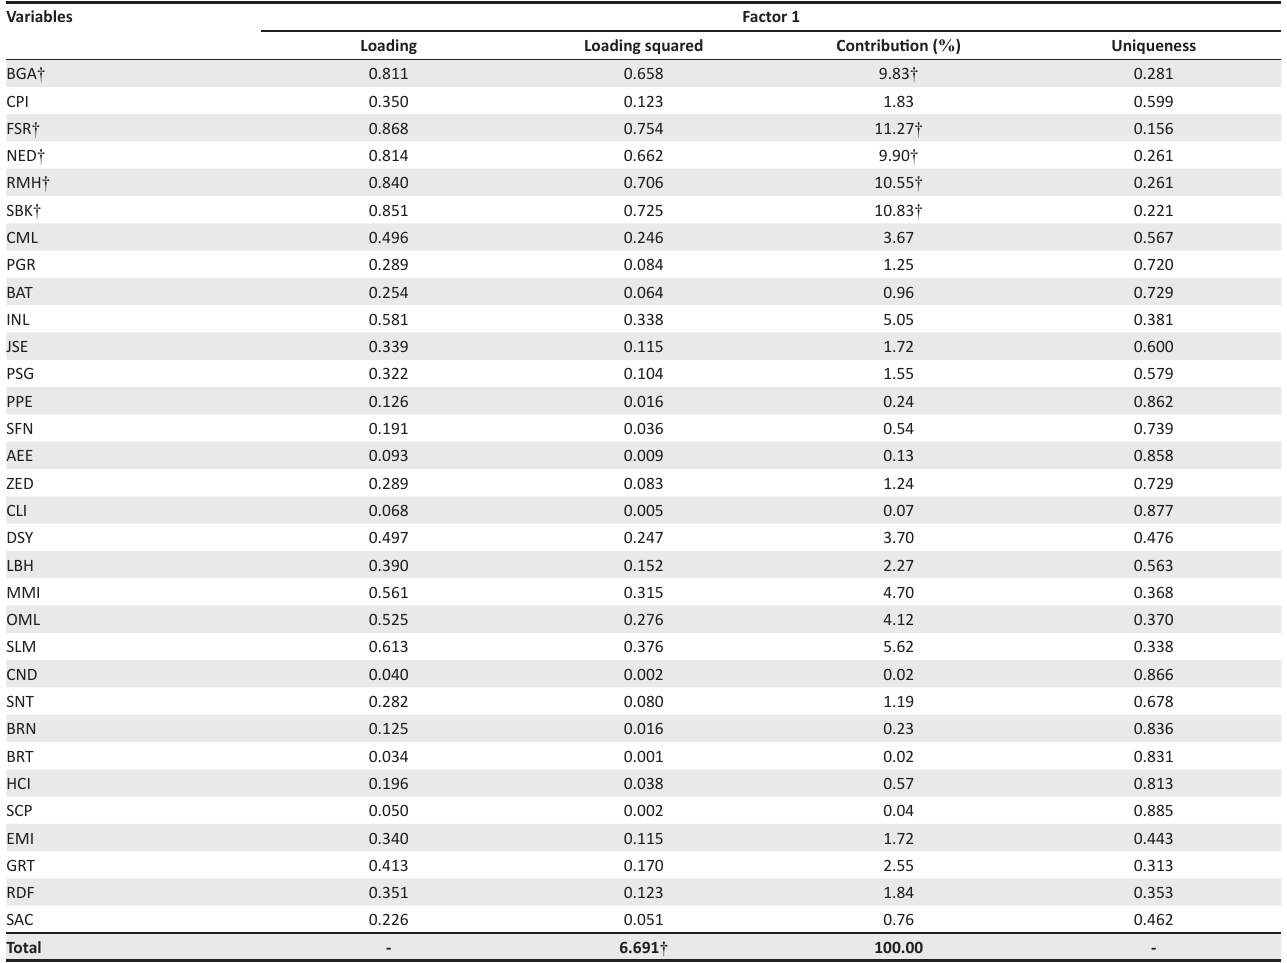
TABLE 4: Contribution to factor variance: 10-year time horizon. Variables Factor